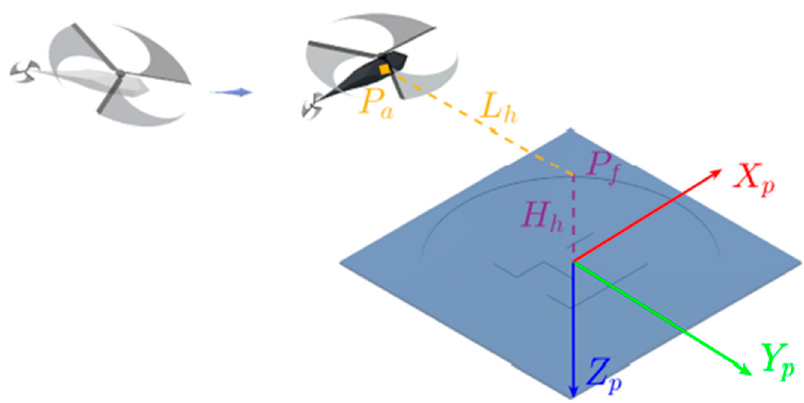
Figure 32. Diagram of approaching stage.